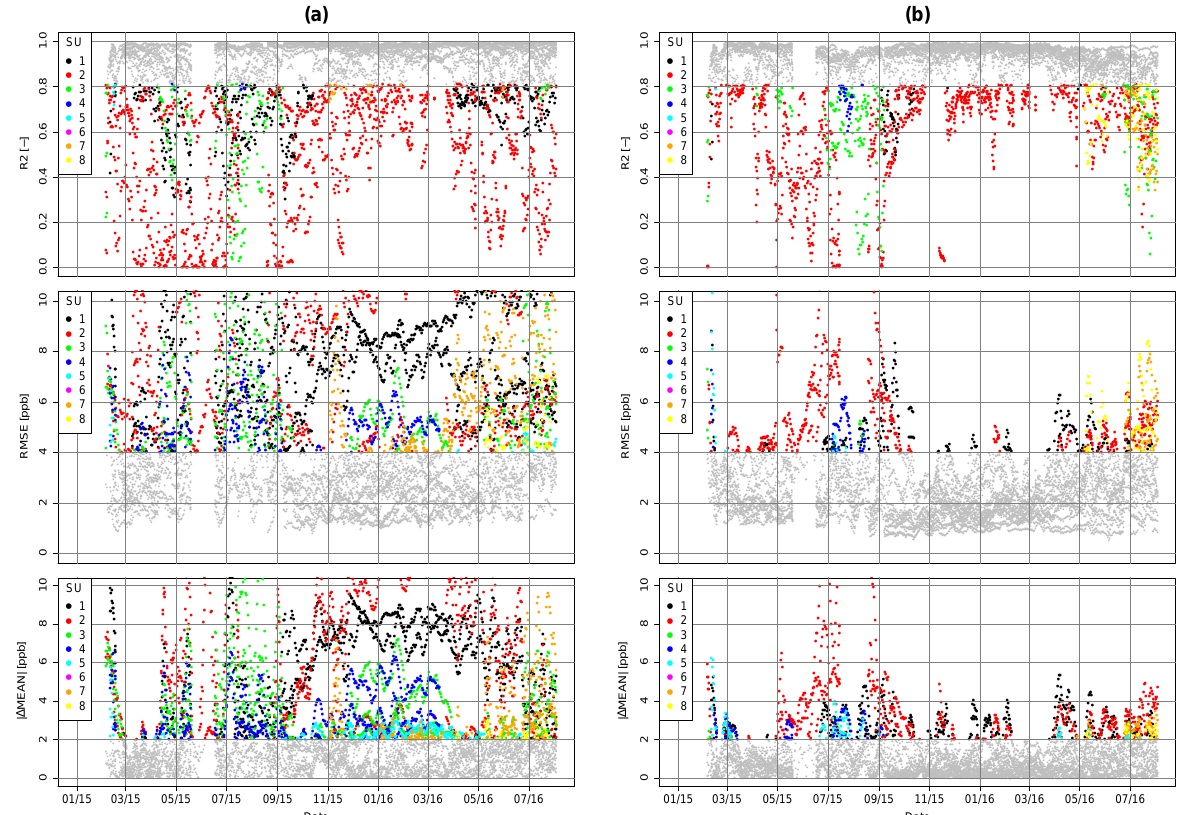
Figure 6. Comparison of measurements from the redundant NO 2 sensors integrated in the SUs by means of the 7-day rolling RMSE, R2 and absolute average difference based on 30min NO 2 concentrations. There are n(n − 1 )/ 2 values for n integrated sensors per day. Only time periods are considered when the SUs were calibrated or operated in the sensor net. The values in (a) are derived from DS 1 which is based on a linear fit only. The values in (b) are derived from DS 3 (calibration PAR/REM; based on Eq. 6). Corresponding results for the O 3 sensors are included in the